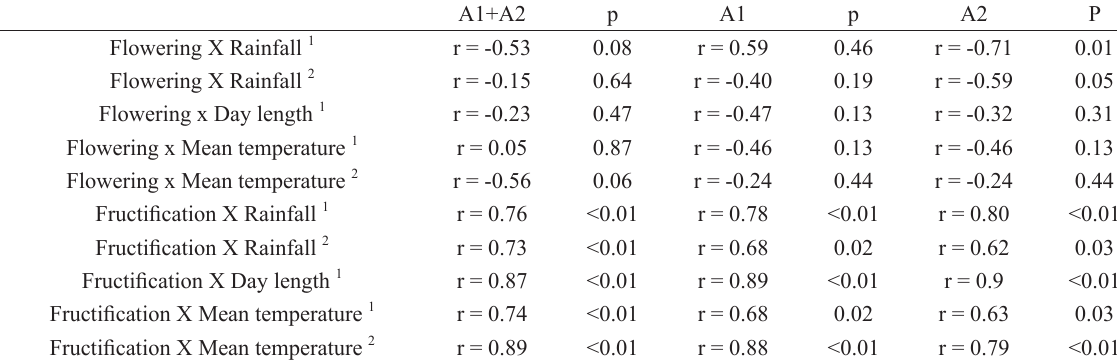
Correlation between abiotic factors and reproductive phenology of trees and bushes on an escarpment slope in the Serra de Maracaju, Mato Grosso do Sul, Brazil. (A1= plots 1,2,3 and 4; A2= plots 5,6,7 and 8; r = result of Spearman analysis; p= significance). 1 Study period, 2 10